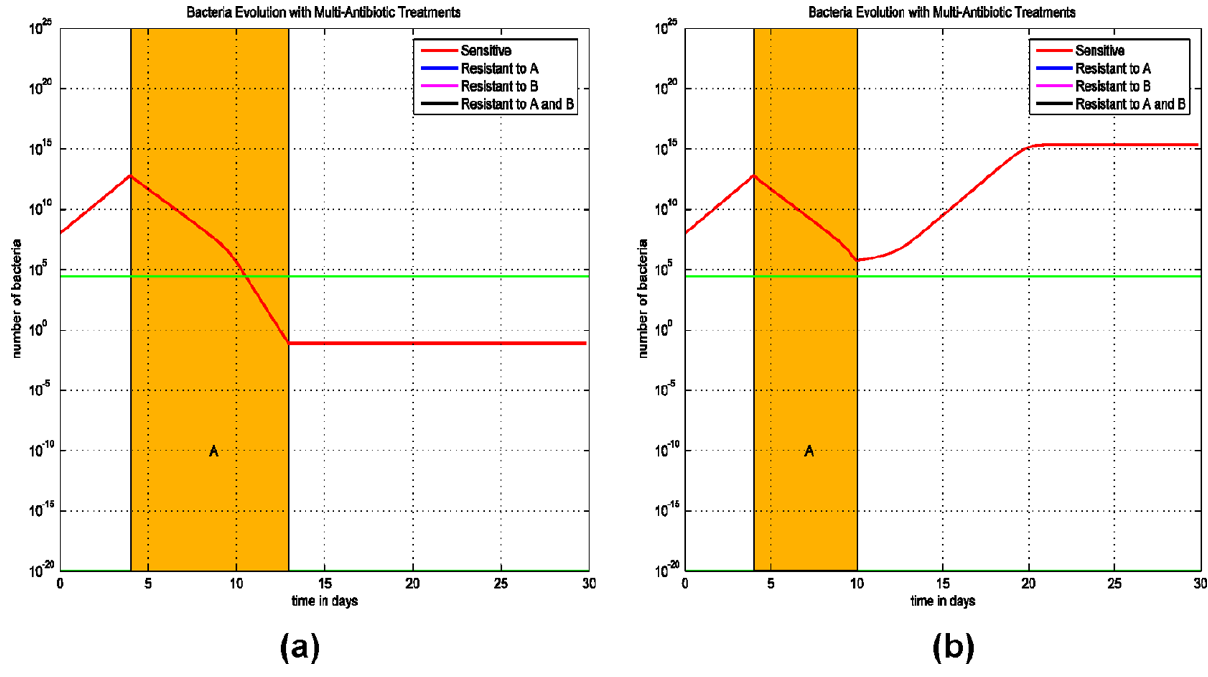
Figure 1. Simulations of Model (1) on the duration of antimicrobial treatment and its effects on infection progression. The initial value is chosen between 10 6 and 10 15 , so the solution increases initially. The green line represents the threshold of bacterial load above which an infection develops. Below this threshold, the phagocyte density is sufficient to prevent the progression to infection. (a) Treatment starts at the 4 th day after an infection and lasts for 9 days. The bacterial load decreases to below the threshold and the infection is prevented. (b) Treatment starts at the 4 th day after an infection and lasts for only 6 days. The bacterial load decreases to close to the threshold, but stays above it and increases again. The infection becomes more